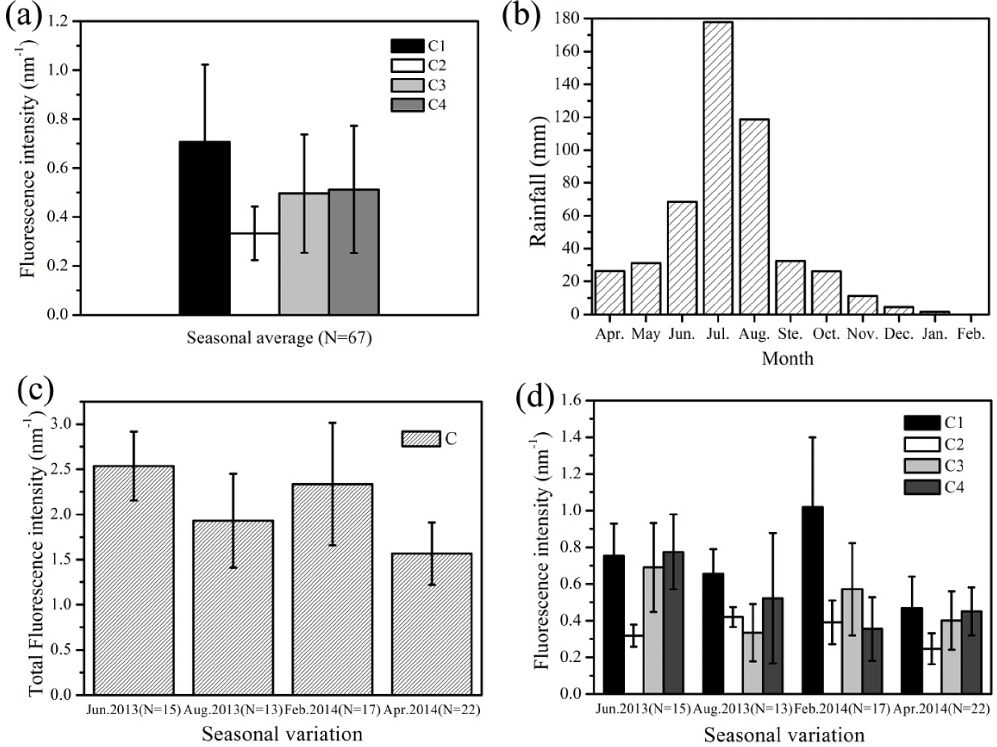
Figure 3. (a) Seasonal average of F max for EEM–PARAFAC components (C1, C2, C3 and C4) for lakes in the western part of Jilin; (b) monthly variation of rainfall for the lakes in the western part of Jilin from April 2013 to February 2014; (c) seasonal variation of the total fluorescence intensity in different seasons; (d) seasonal variation of the four EEM–PARAFAC components in different seasons. The error bars represent 1 standard